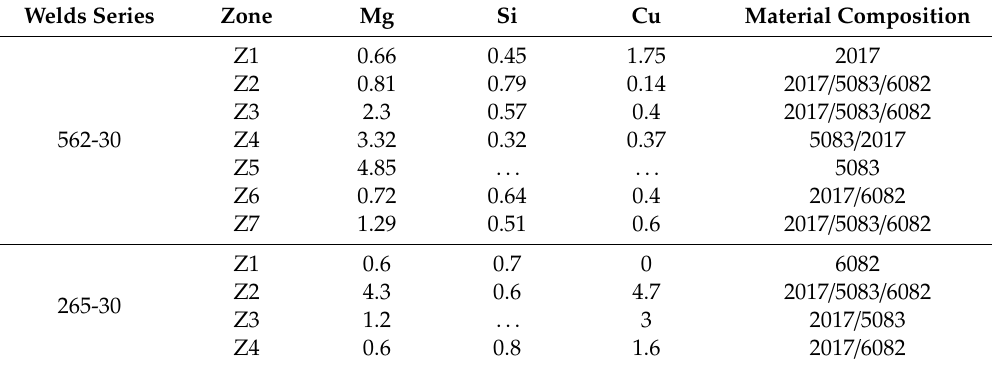
AA2017. The second onion ring structure indicated by ellipse 2—zone 3—had interleaved layers